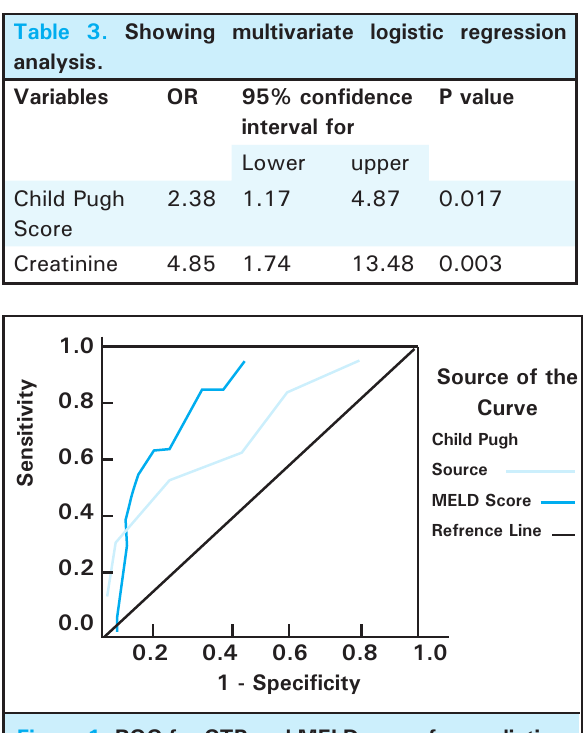
Figure 1. ROC for CTP and MELD score for predicting mortality.